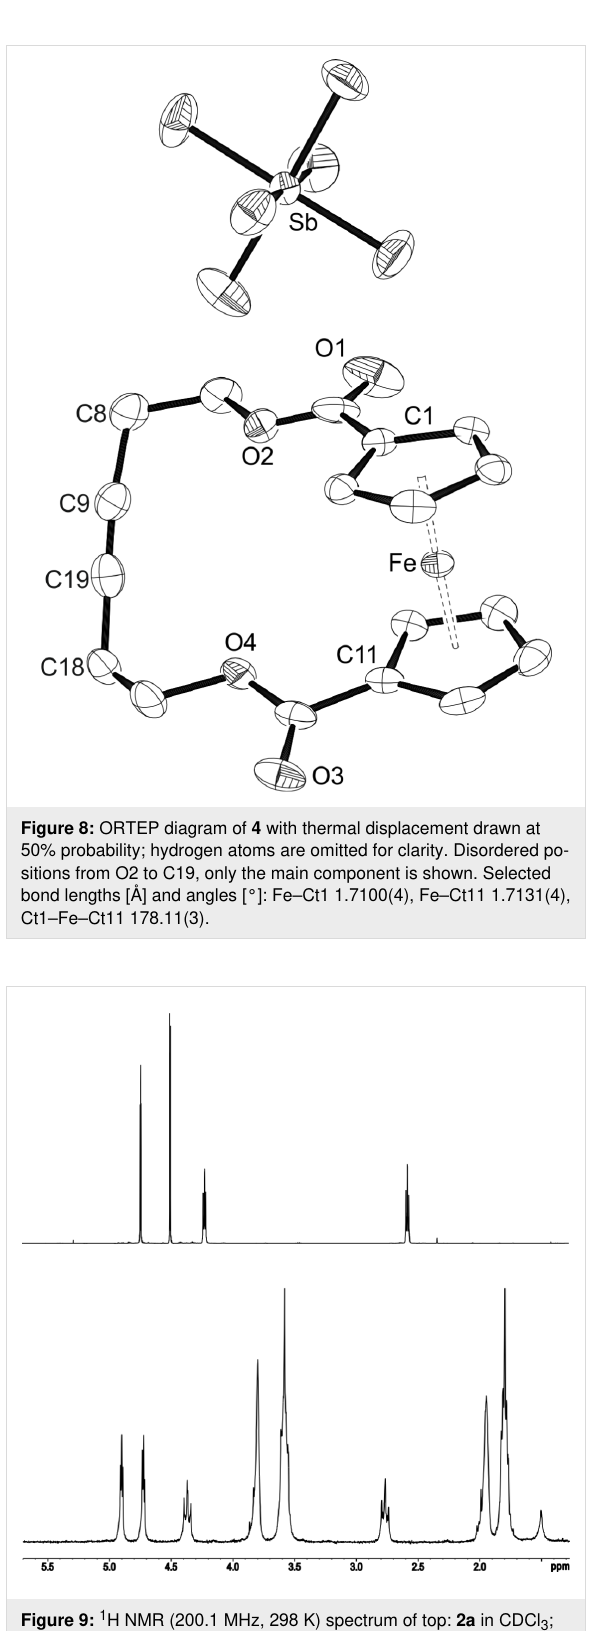
Figure 9: 1 H NMR (200.1 MHz, 298 K) spectrum of top: 2a in CDCl 3 ; bottom: 5 in THF- d 8 – signals for solvate THF occur at 3.80 ppm and 1.95